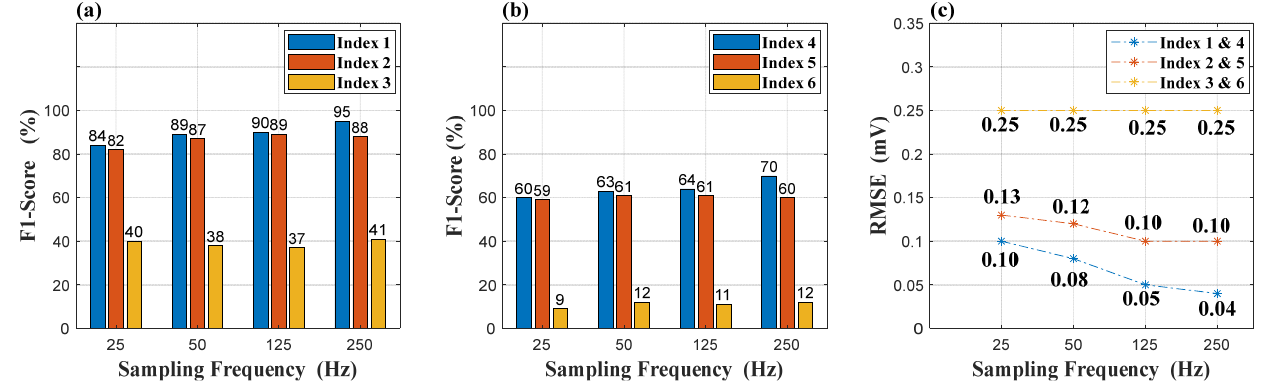
Figure 6. Experimental results: ( a ) is the result of Group 1. ( b ) is the result of Group 2. ( c ) is the RMSE result of Groups 1 and 2. RMSE is the abbreviation of the root mean square error.